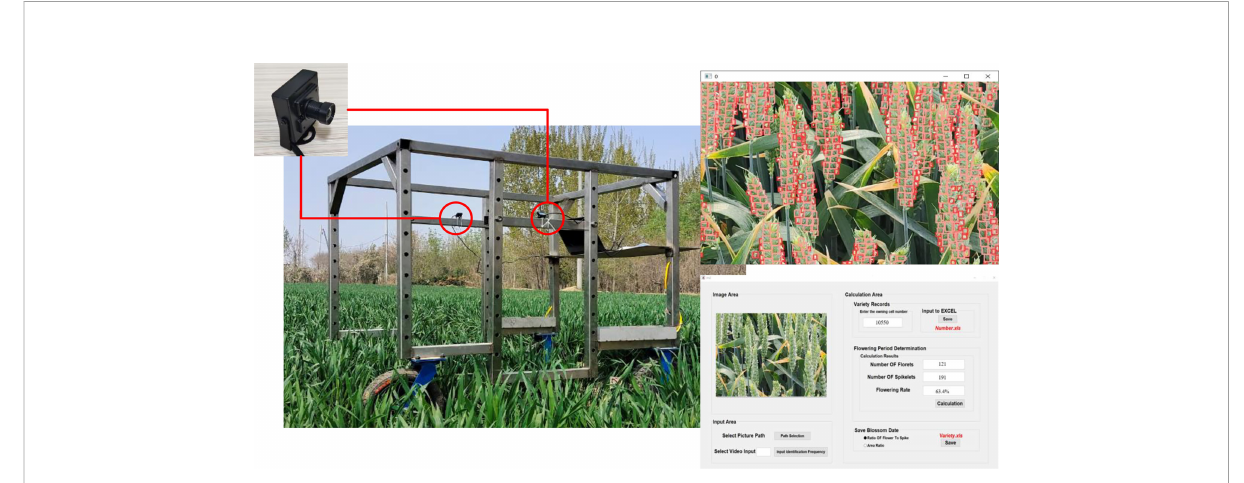
FIGURE 15 Field experiment process.